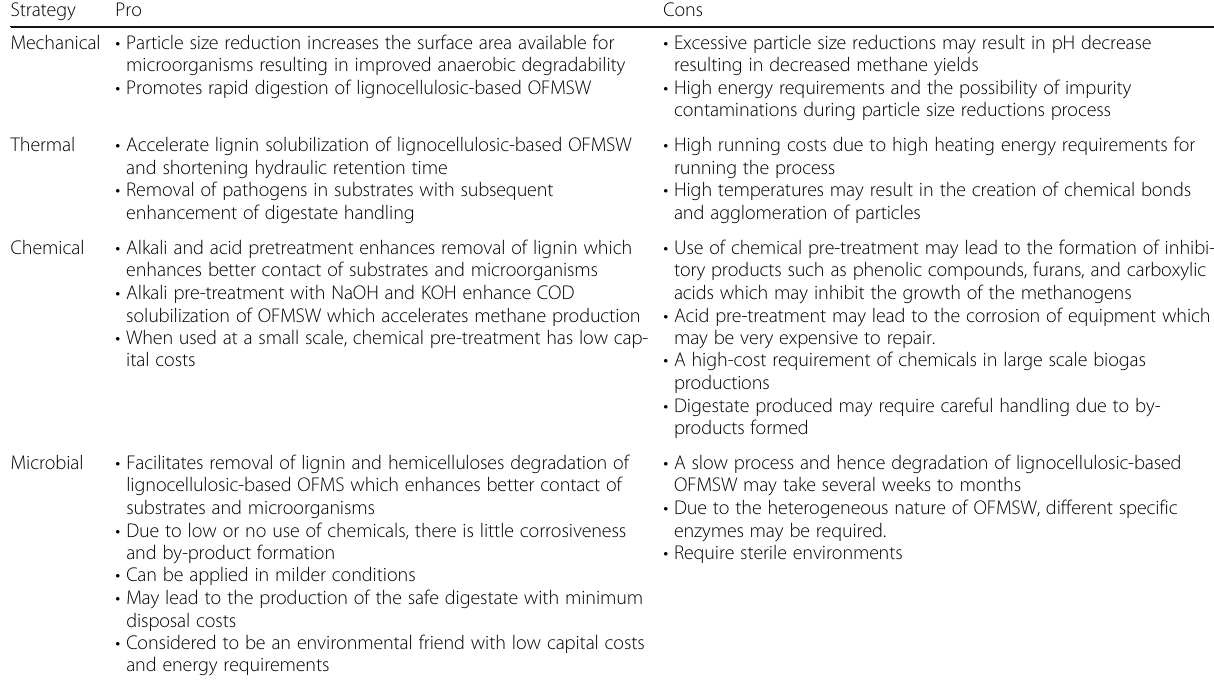
Table 5 Summary of pro and cons of pretreatment strategies to optimize the hydrolysis stage Strategy Pro